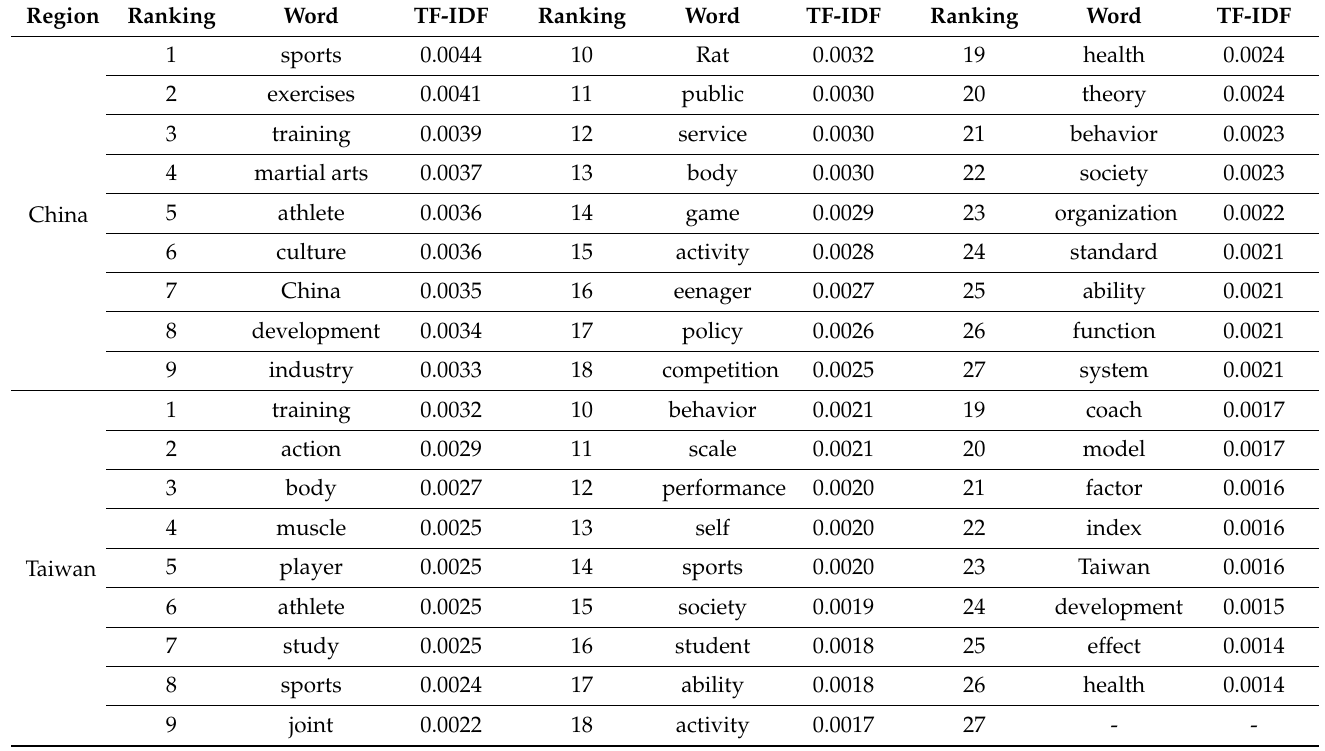
Table 2. TF-IDF analysis